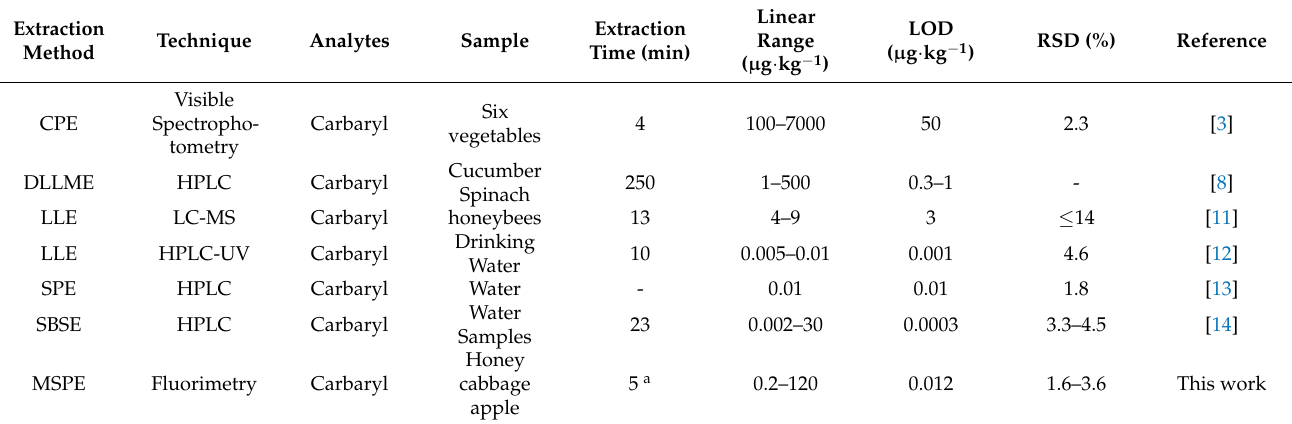
Table 4. Comparison to previously proposed